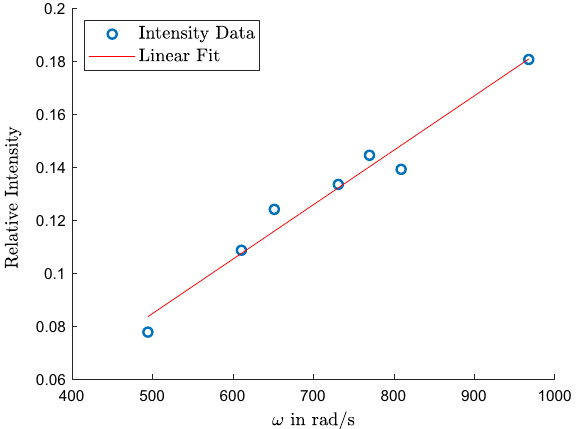
Figure 6. Relative intensity of the LED in case 5 for different speeds of rotation. An intensity value of 1 represents an entirely white